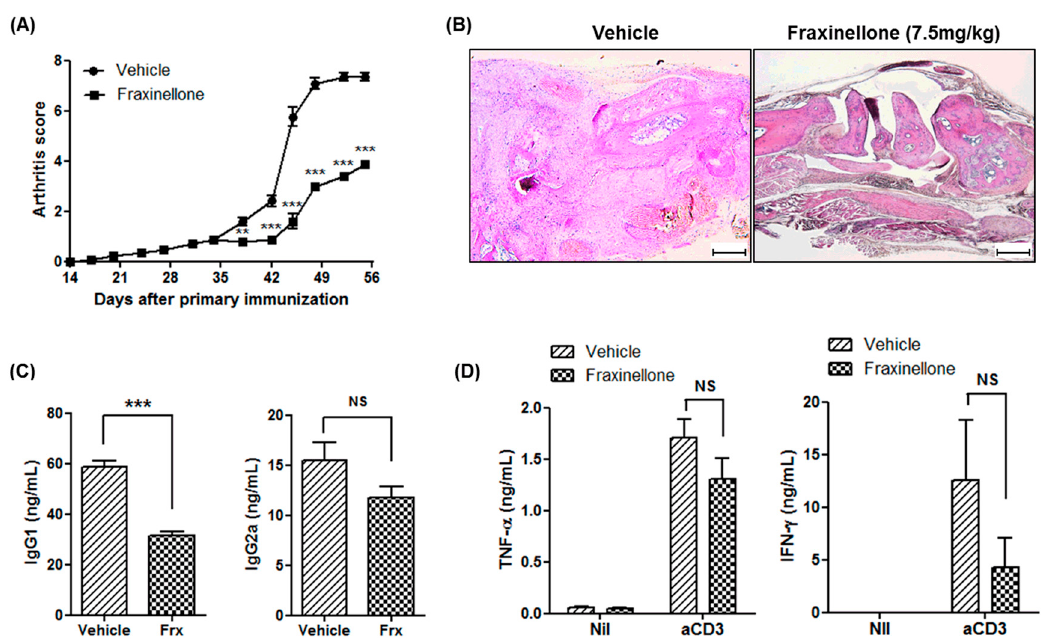
Figure 1. Fraxinellone attenuates inflammatory arthritis in mice. ( A ) Mice with collagen-induced arthritis (CIA) were treated with fraxinellone (7.5 mg/kg) or the vehicle control ( n = 10 in each group). The arthritic score was defined as the sum of the scores of three paws (excluding the boosted paw); scores ranged from 0 to 12. ( B ) Tarsal joint tissues of CIA mice treated with fraxinellone or the control vehicle were stained with haematoxylin & eosin. The scale bars at the bottom right of the images indicate 200 µ m. ( C ) Serum levels of IgG1 and IgG2a of CIA mice were determined using an enzyme-linked immunosorbent assay (ELISA). ( D ) Splenocytes of CIA mice were stimulated with or without anti-CD3 antibodies. The level of TNF- α and IFN- γ in culture media were measured by ELISA. Data are expressed as mean ± standard error of the mean (SEM). IgG1, immunoglobulin G1; IgG2a, immunoglobulin G2a; Frx, fraxinellone; TNF- α , tumor necrosis factor- α ; IFN- γ , interferon- γ ; Nil, no treatment; aCD3, stimulation with anti-CD3 antibodies; NS, not significant; ** p < 0.01; *** p < 0.001.